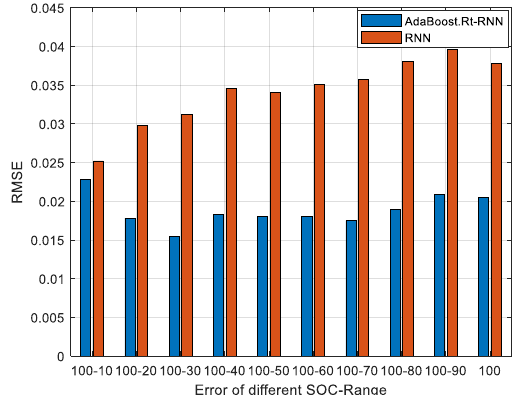
Figure 12. RMSE of AdaBoost.Rt-RNN and RNN.